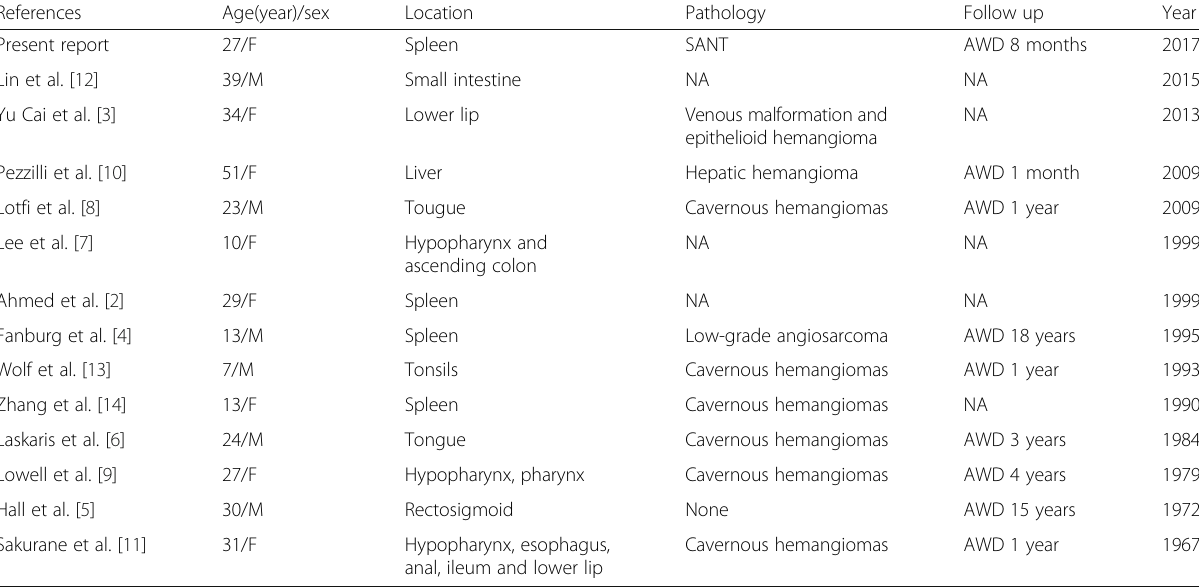
Table 1 Cases of Maffucci syndrome with vascular lesions presenting in non-cutaneous